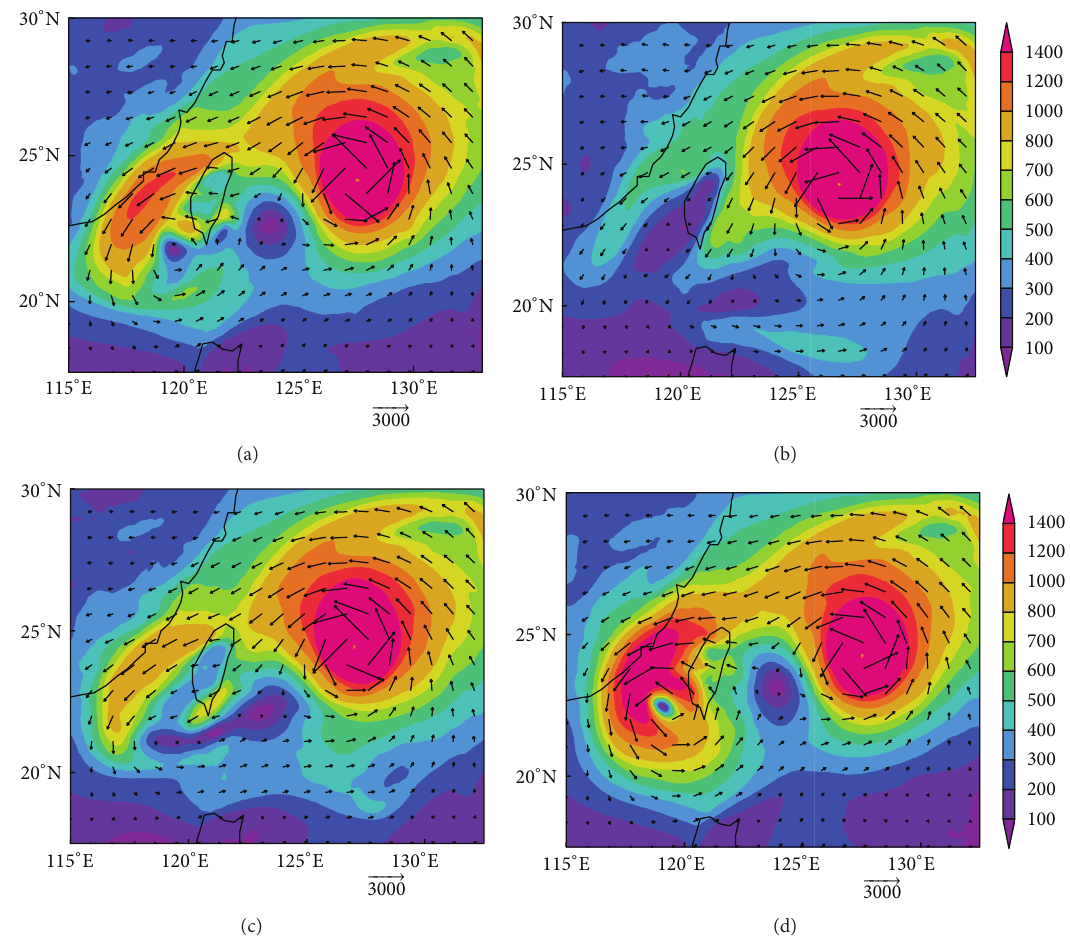
Figure 9: Simulated volume moisture fluxes (vectors) with their magnitude (shaded, kgm −1 s −1 ) for CNTR (a), Bopha rm (b), Bopha wk (c), and Bopha str (d) at 0600 UTC 09 August,